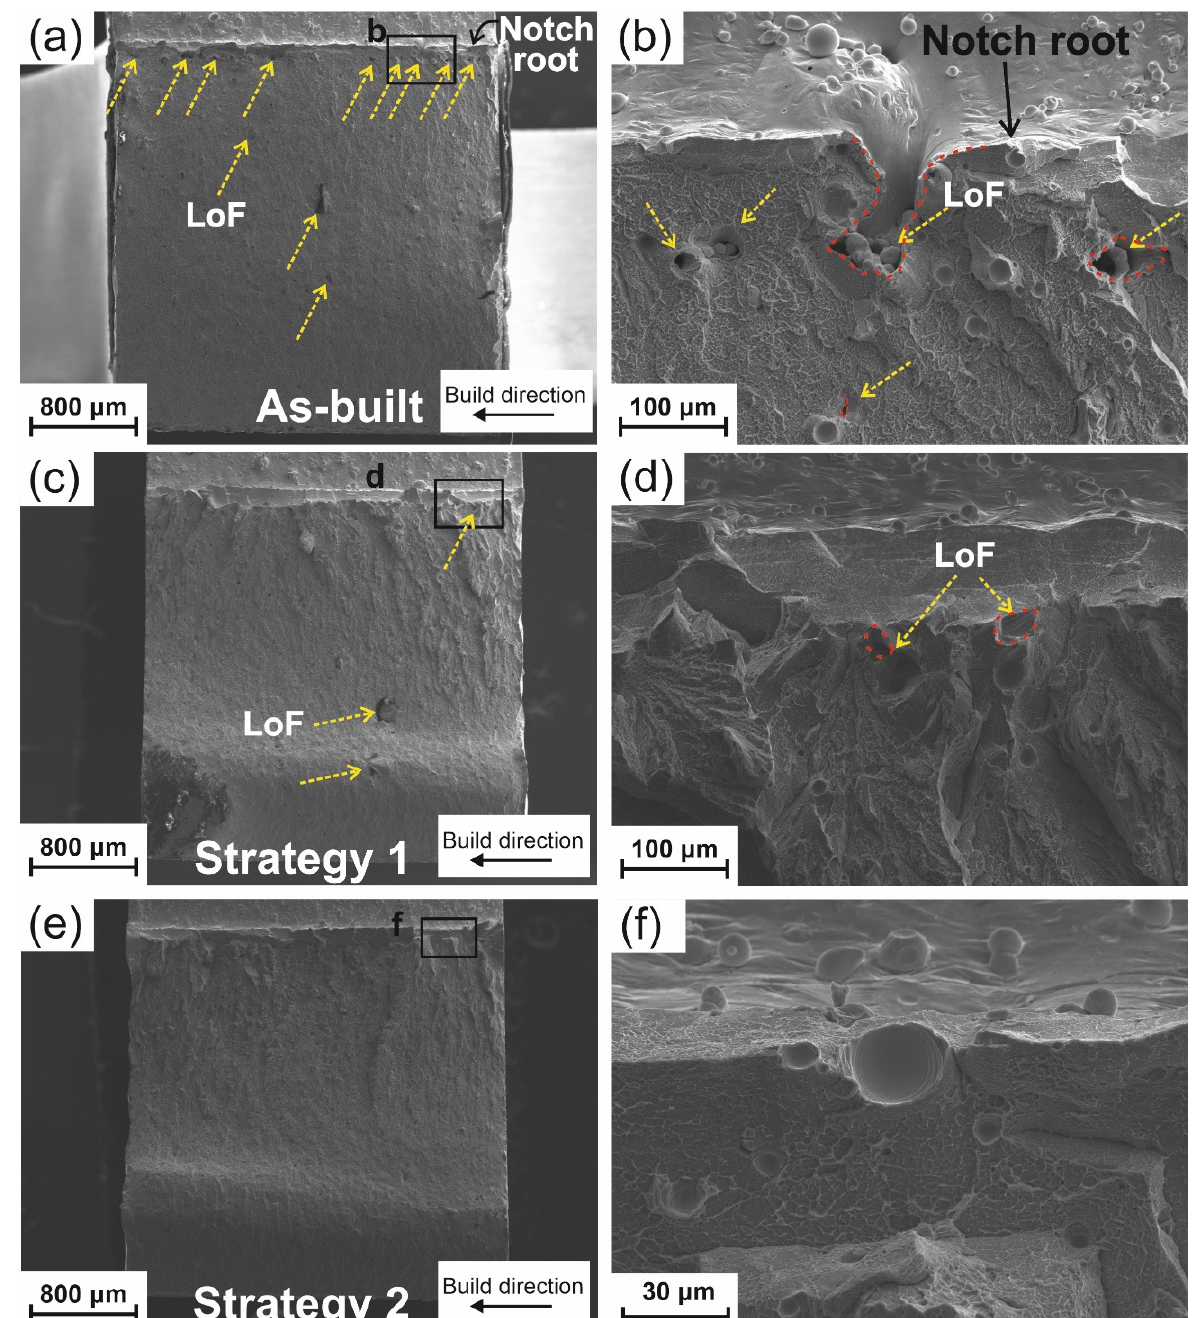
Figure 48. Fracture surface of the CIT samples in ( a , b ) as-built condition, ( c , d ) Strategy 1, by only decreasing the border distance and increasing border laser power, and ( e , f ) Strategy 2, increasing the core power in addition to changing the border parameters [78].